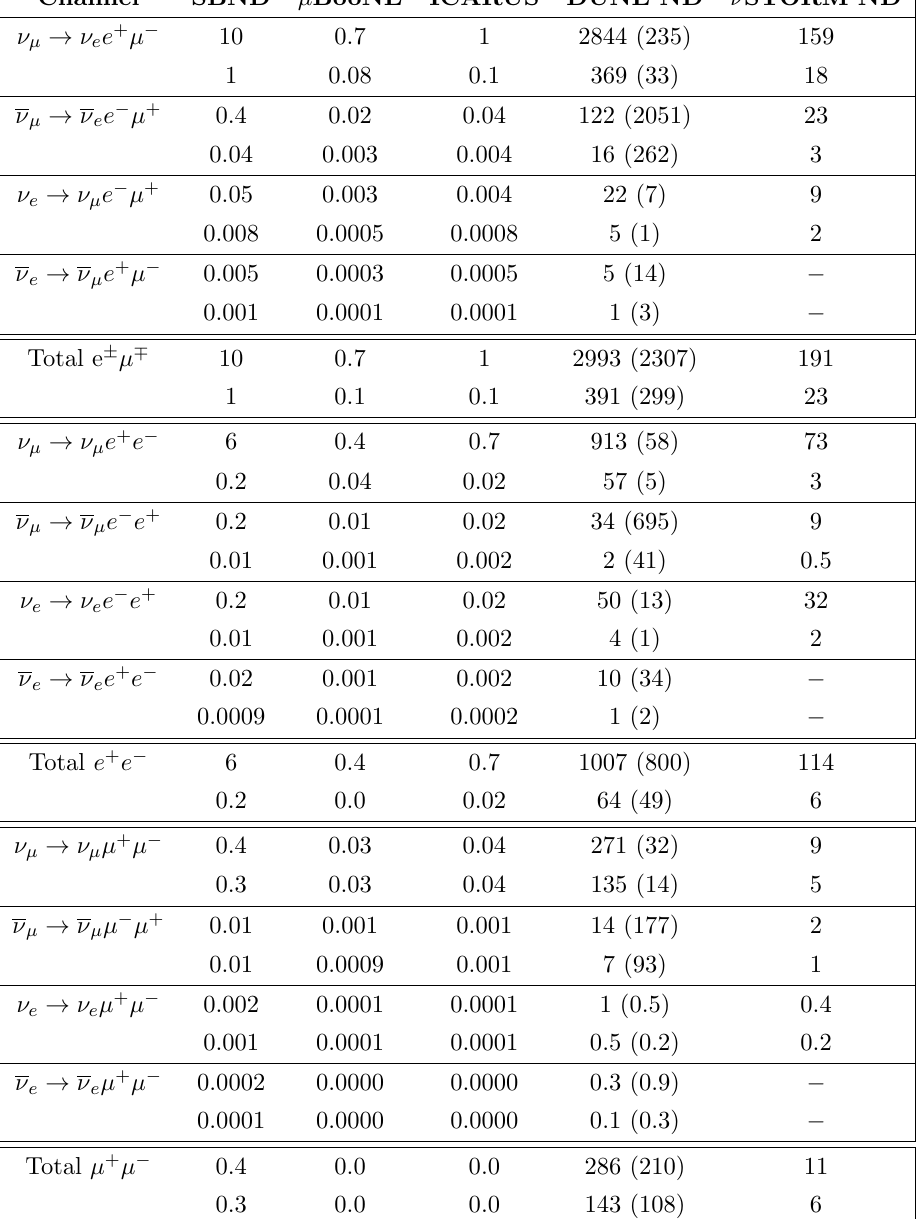
Table 3 . Total number of coherent (top row) and di(cid:11)ractive (bottom row) trident events expected at di(cid:11)erent LAr experiments for a given channel. The numbers in parentheses are for the antineu- trino running mode, when present. These calculations considered a detector e(cid:14)ciency of